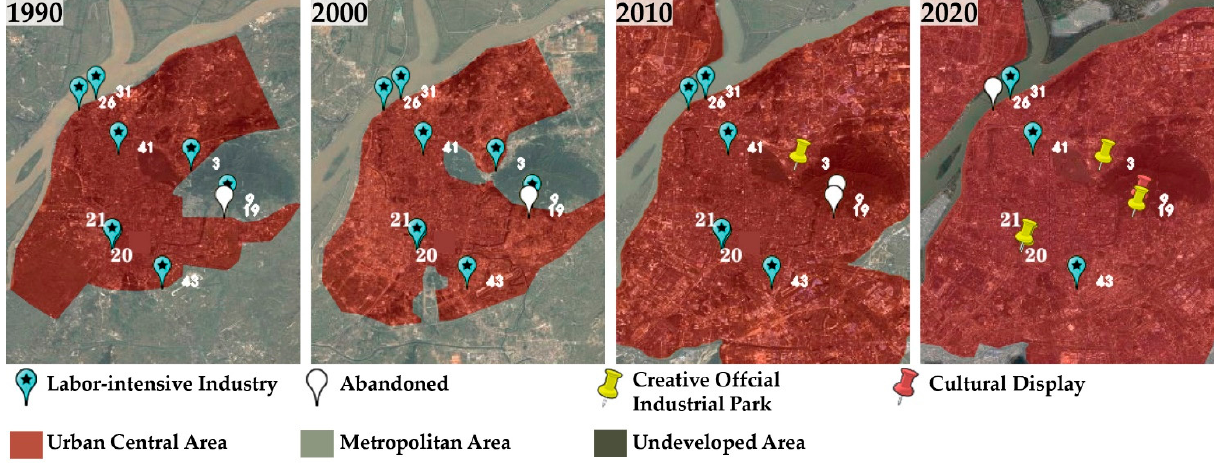
Figure 10. The change in the relationship between the operation state of labor-intensive industries and urban growth boundary over time (Figure source: own drawing; data source: on-site investigation and interview).